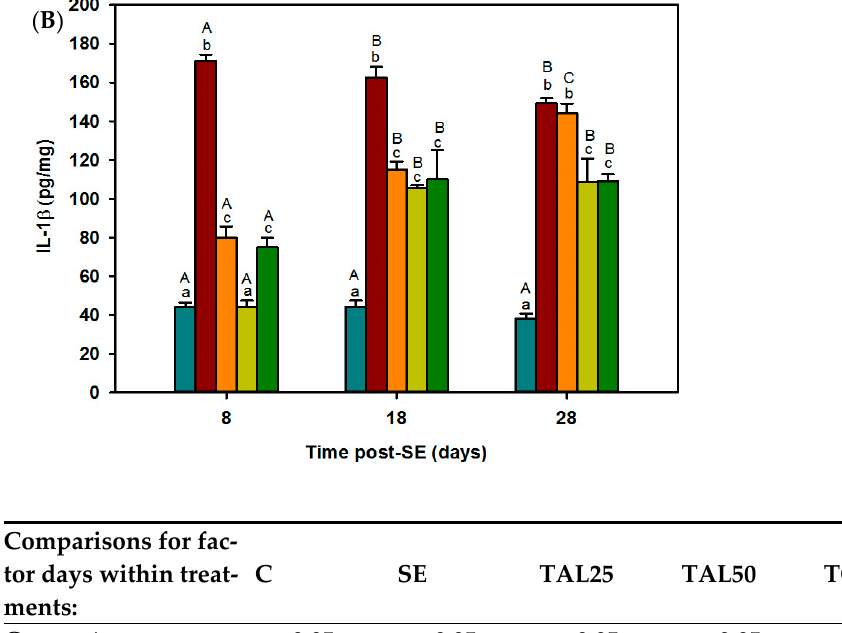
Comparisons for fac- tor days within treat- ments: Comparison 28 vs. 18 18 vs. 8 Comparisons for factor treat- ments within days: Comparison TOP vs. C Yes Yes TOP vs. SE TOP vs. TAL25 TOP vs. TAL50 TAL50 vs. C TAL50 vs. SE TAL50 vs. TAL25 TAL25 vs. C TAL25 vs. SE SE vs. C Figure 2. Cont